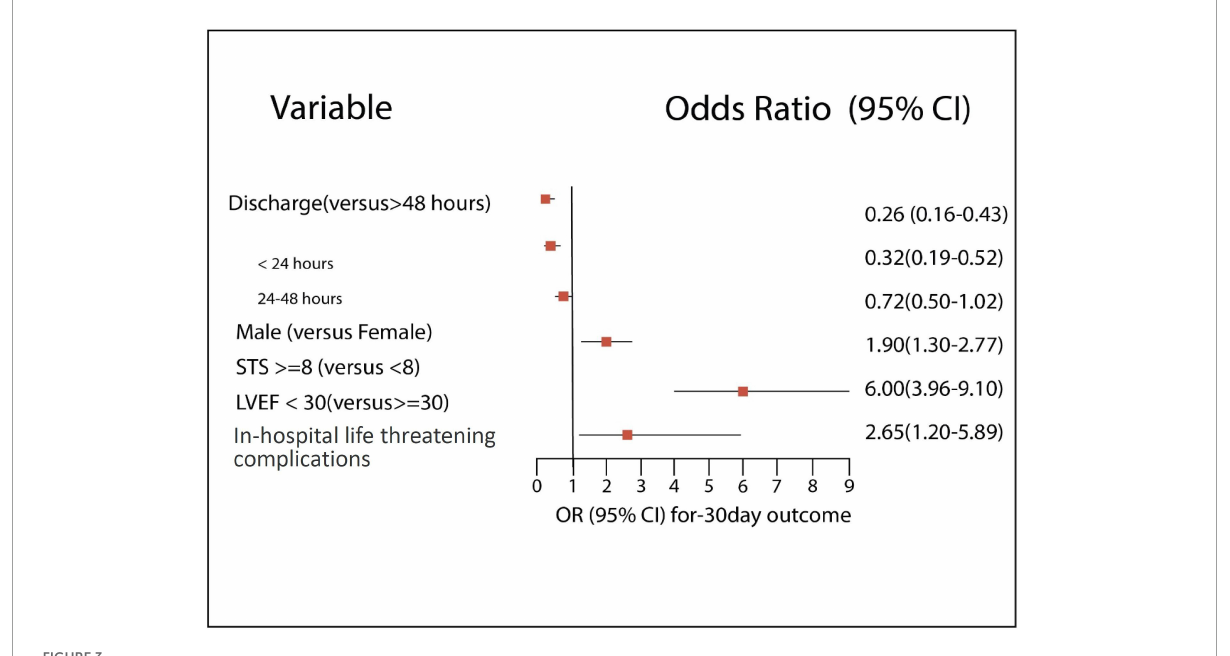
FIGURE3 Significant predictors for 30-day outcomes.